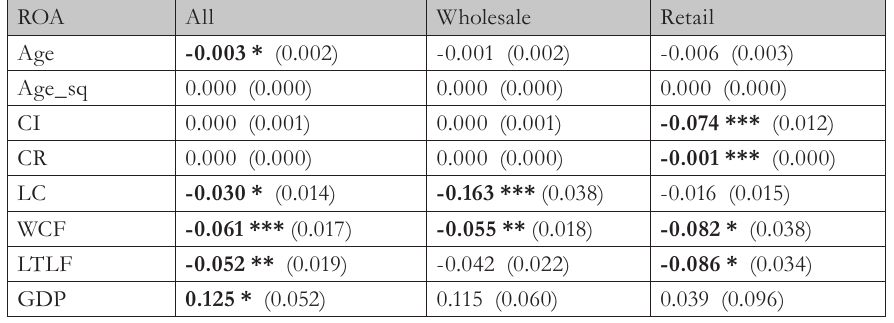
Tab. 3 – Determinants of operating performance (ROA): estimation results (standard errors in parentheses). Source: own